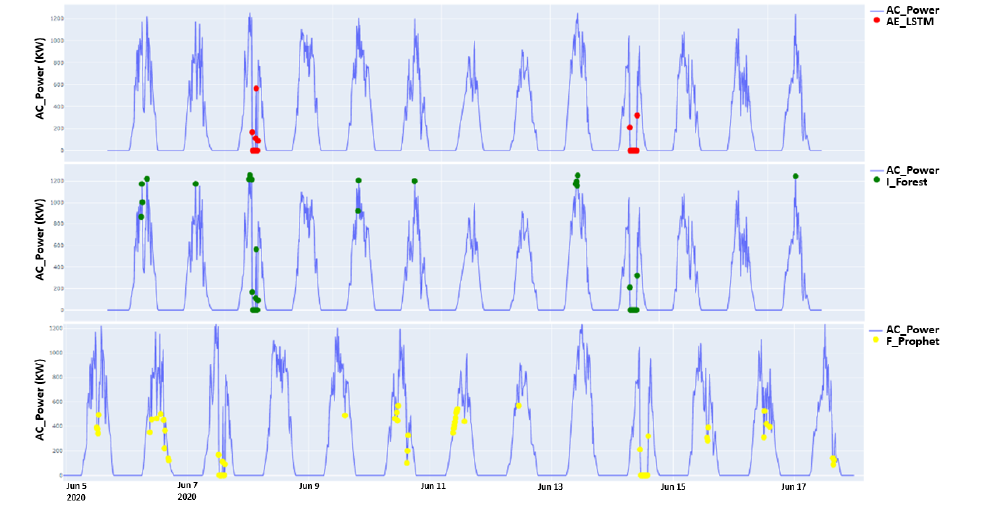
Figure 7. Anomaly detection outcomes from the three models on a faulty AC Power signal.